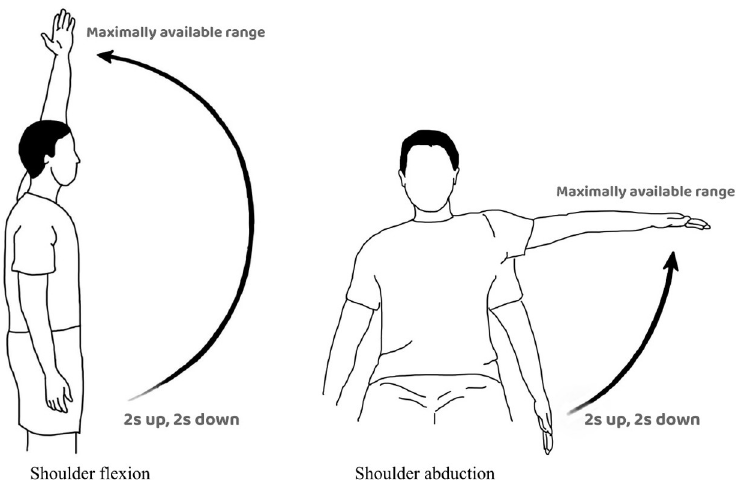
Fig 3. Standardized functional tasks–shoulder flexion and shoulder